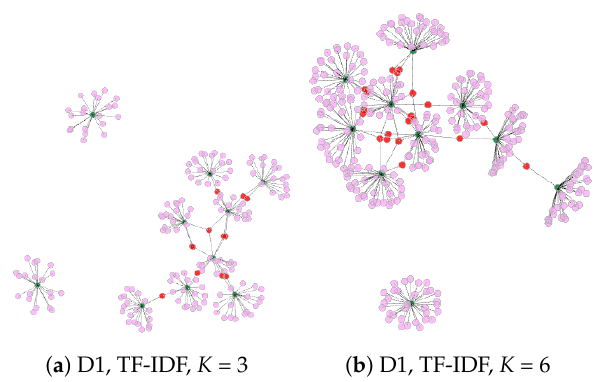
Figure 14. D1 graph representation, TF-IDF weighting scheme, K = 10, probabilistic approach, considering the top-20 ( a ) and the top-40 ( b )